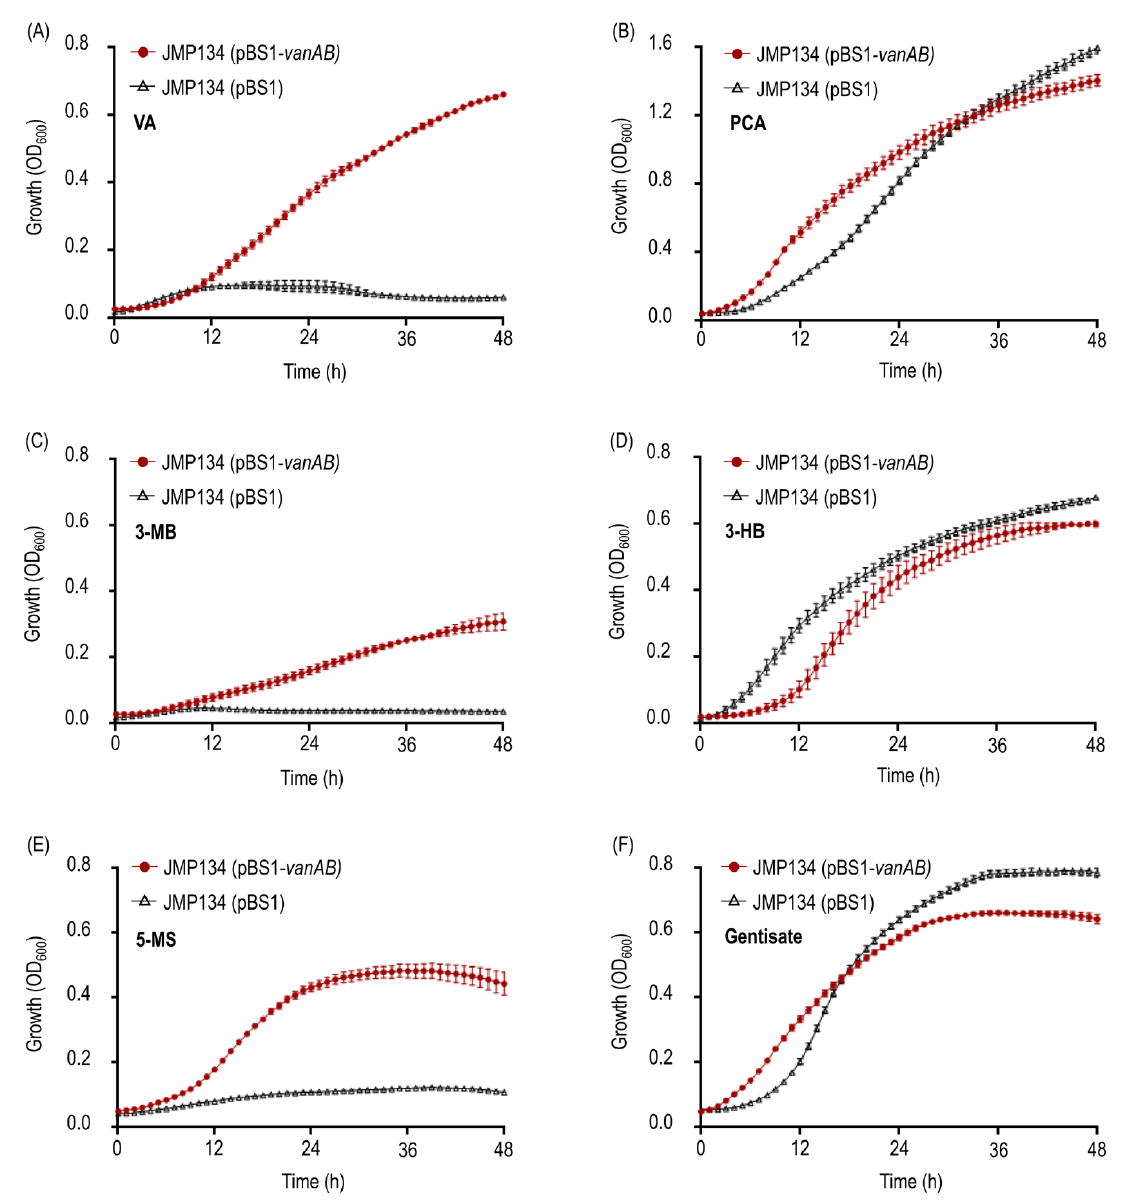
Figure 2. Growth on meta -methoxylated aromatic acids, VA, 3-MB, and 5-CS, and their O-demethylation products of Cupriavidus pinatubonensis JMP134 expressing vanAB genes of R. ruber R1. Growth of C. pinatubonensis JMP134 expressing vanAB genes driven by a heterologous P BAD promoter on 5 mM ( A ) VA, ( B ) PCA, ( C ) 3-MB, ( D ) 3-HB, ( E ) 5-MS, or ( F ) gentisate as sole carbon and energy sources was assayed in the presence of 1 mM L-arabinose as inducer. Three biological replicates were performed for growth measurements. Error bars indicate the SEM.